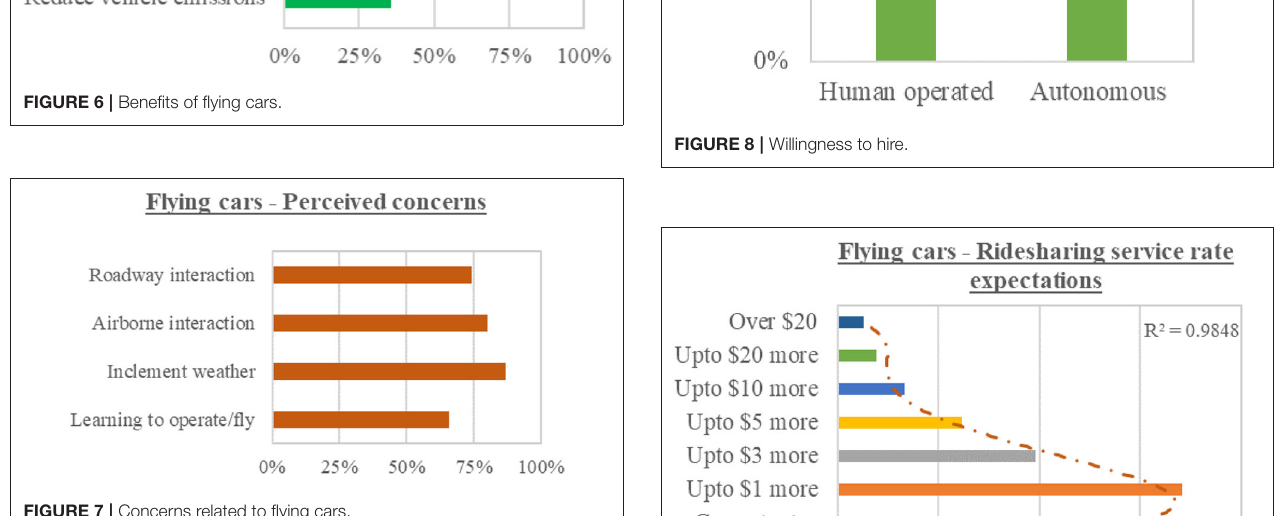
FIGURE 7 | Concerns related to flying cars.